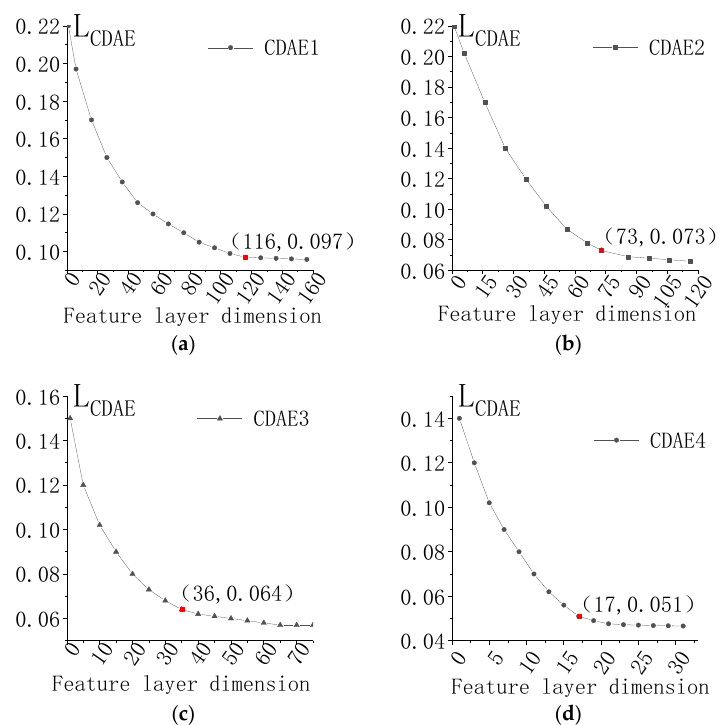
Figure 7. ( a ), ( b ), ( c ), ( d ) are the loss values of the first layer, the second layer, the third layer, and the fourth layer of the SCDAE training process.